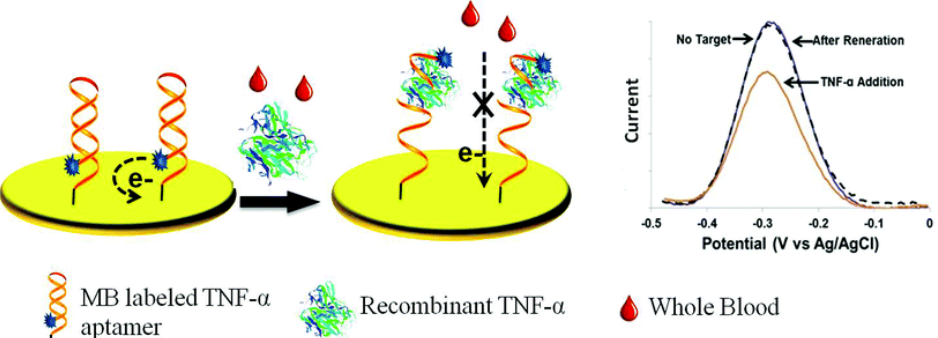
Figure 3. Schematic representation of an TNF- α aptasensor with methylene blue (MB) as a redox label. In the absence of the target, Apt hairpins remain folded with MB reporters in proximity to the electrode, ensuring efficient electron transfer and a measurable faradaic current. Upon target binding, the redox tag moves far away from the electrode and the redox current decreases. Reprinted from [106] with permission from The Royal Society of Chemistry.